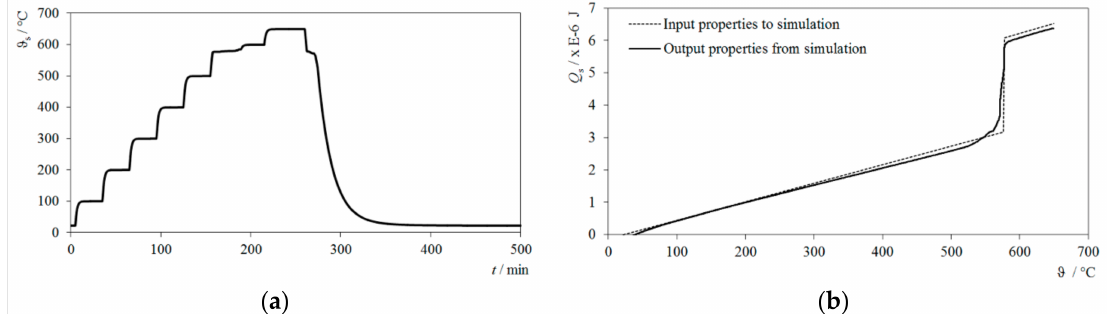
Figure 7. Results of isoperibolic procedure with loss correlation. ( a ) Course of simulated sample temperature over time . m = 50 kg/h. ( b ) Course of Q S curve resulting from simulation (solid) compared to curve resulting with t eq = 30 min and from simulation input values (broken).